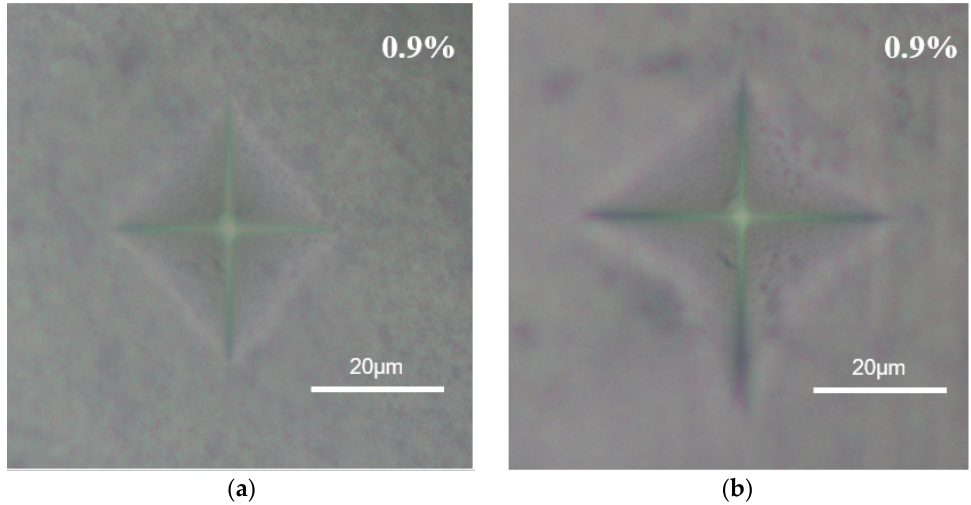
Figure 6. Optical microscope of the 3Y-TZP ceramics added with 0.9 wt% nano TiO 2 powders. ( a ) as microwave-sintered and ( b ) under the treatment of citric acid corrosion for 10 h.